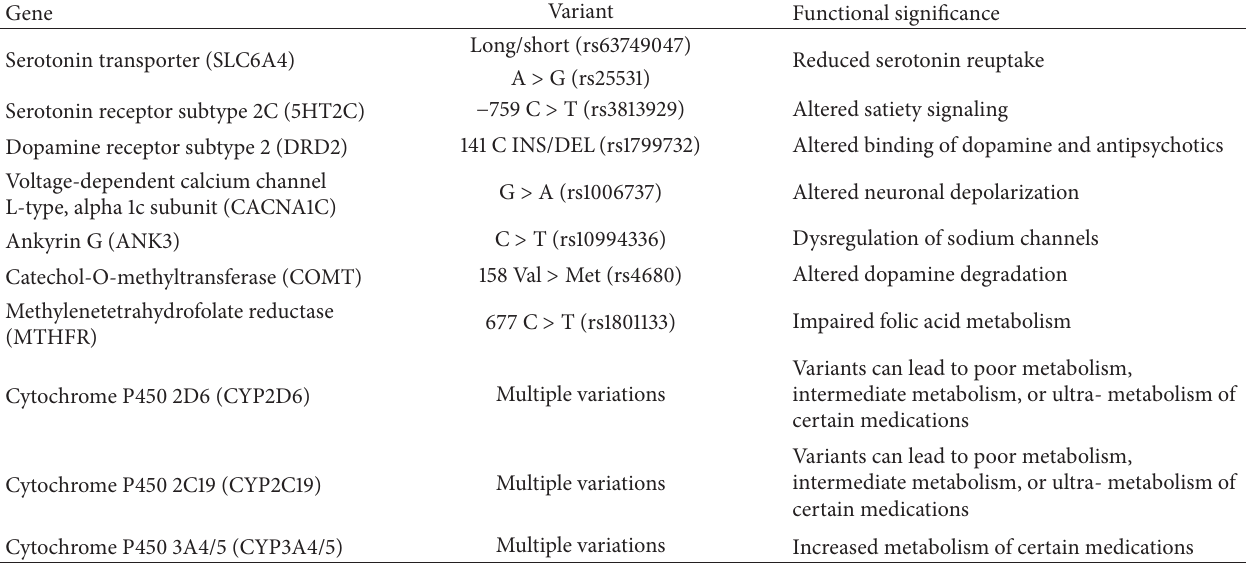
Table 1: Genes tested using the Genecept